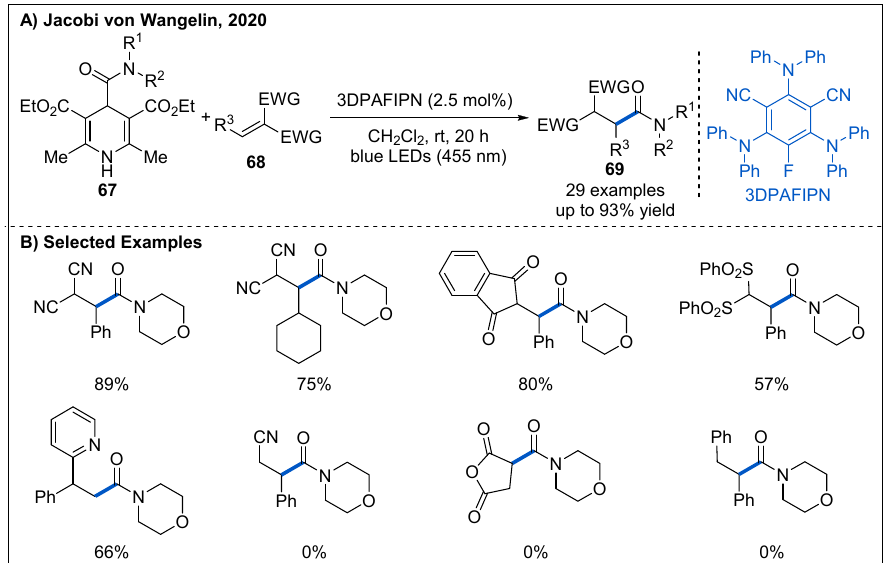
Figure 22. Amide synthesis by photoredox-catalyzed addition of 4-carboxamido-1,4-dihydropyridine to olefins.